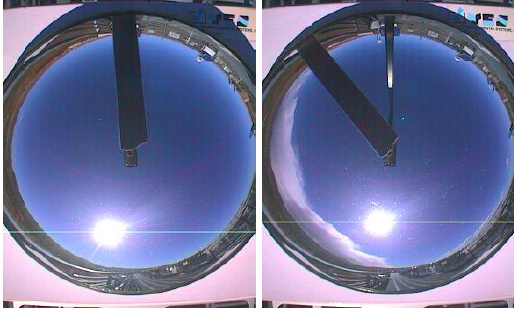
Figure 4. Images from 2015 and 2016, respectively, where the sun-tracker has stopped